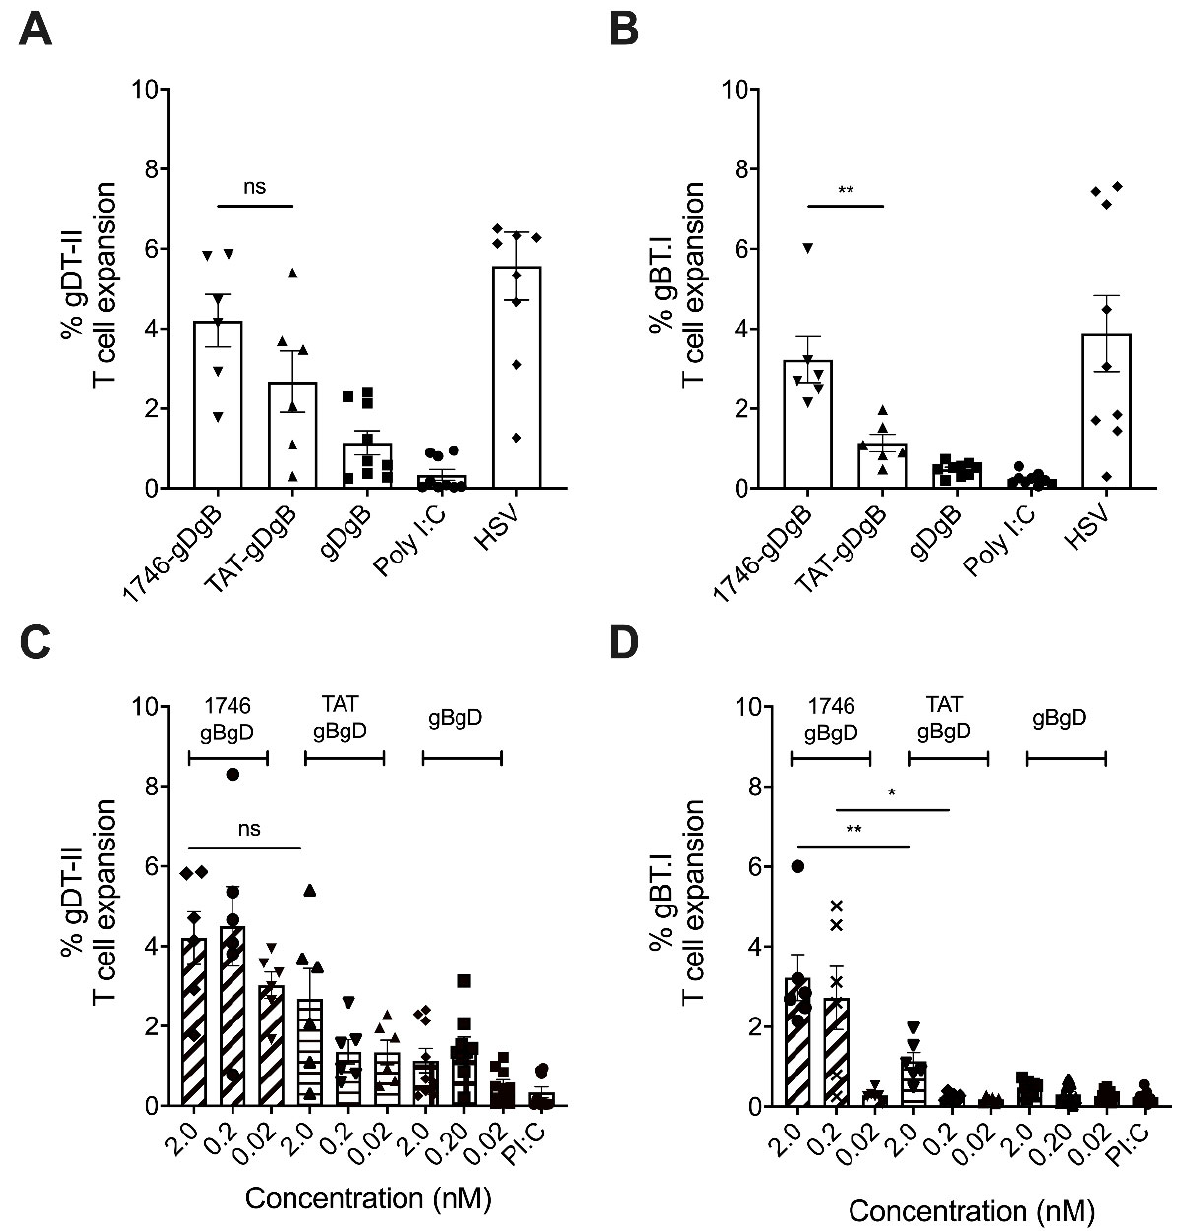
Figure 3. Non-targeted 1746-gBgD vaccine capable of endosomal escape drives robust expansion of gBT.I CD8 + T cells at 10-fold lower concentration than TAT-gBgD vaccine. Treatment schedule; mice received adoptive transfer of 1 × 10 5 gBT.I and 1 × 10 4 gDT.II T cells prior to subcutaneous prime and boost vaccinations with 2 nM, 0.2 nM or 0.02 nM of vaccine constructs plus 50 ug Poly(I:C). ( A ) gDT.II and ( B ) gBT.I T cell expansion after vaccination with 2 nM of non-targeted vaccine constructs was measured as percentage of the total CD4 + or CD8 + pool 7 days after the boost vaccination. Data are from two or three independent experiments and n = 6 or n = 9 for each group, displayed as mean +/ − SEM. ( C ) gDT.II and ( D ) gBT.I T cell expansion after vaccination with 2 nM, 0.2 nM or 0.02 nM of untargeted vaccine constructs was measured as percentage of the total CD4 + or CD8 + pool 7 days after the boost vaccination. Data are from two or three independent experiments and n = 6 or n = 9 for each group, displayed as mean +/ − SEM. ** p < 0.01, * p < 0.05, ns = not significant. Diagonal bars = 1746-gDgB, Vertical bars = TAT-gDgB, Squares = gDgB.